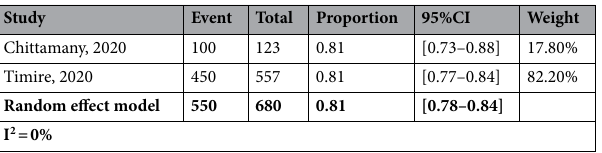
Table 4. Pooled proportion of catastrophic costs at 20% among TB and HIV infected